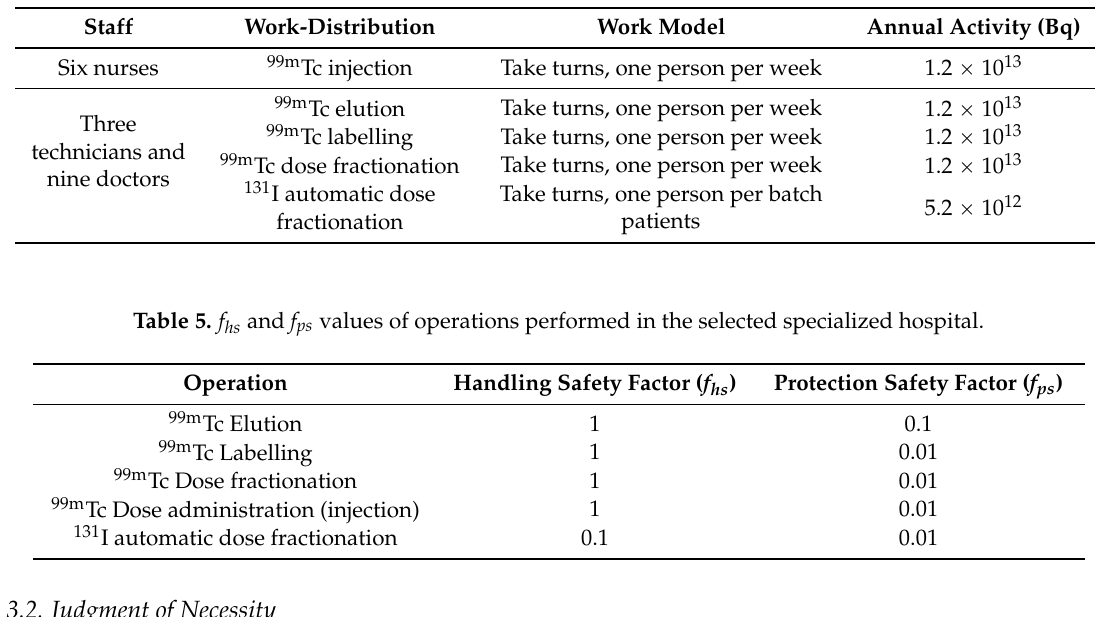
Table 4. Collected information in the selected specialized hospital.